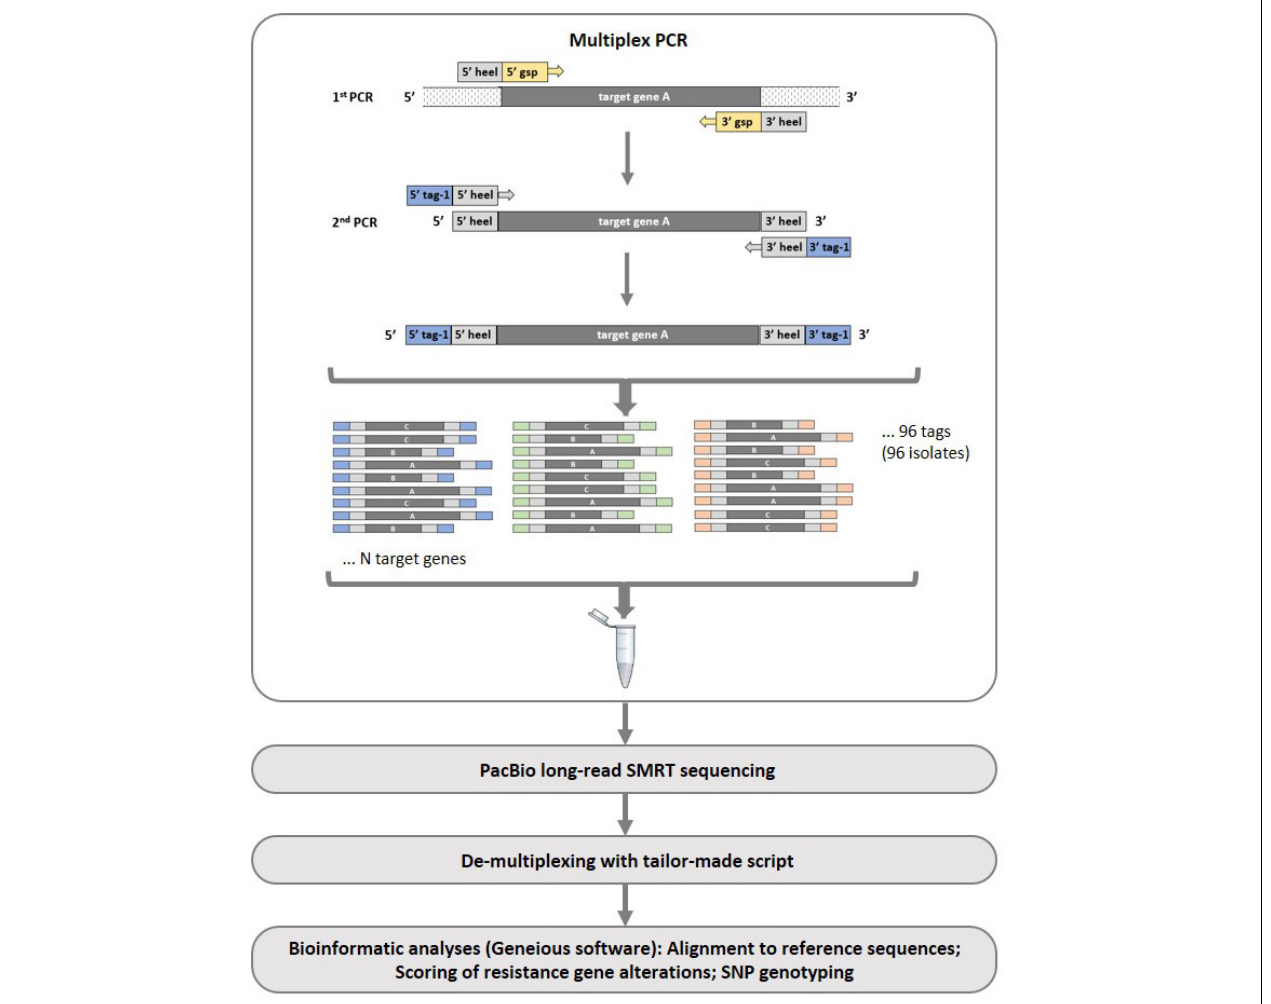
FIGURE 1 | Illustration of the multiplex PCR principal and workflow applied in the PacBio long-read sequencing assay development. In the first multiplex PCR reaction, a number of gene-specific primers (gsp) with heel sequences are used. In the second multiplex PCR reaction, unique tags (one for each reaction tube) are added and used as indexing primers. For simplicity, only one multiplex PCR is shown in the figure, however, amplifications were divided into two PCRs (“A” and “B”) in the current study.